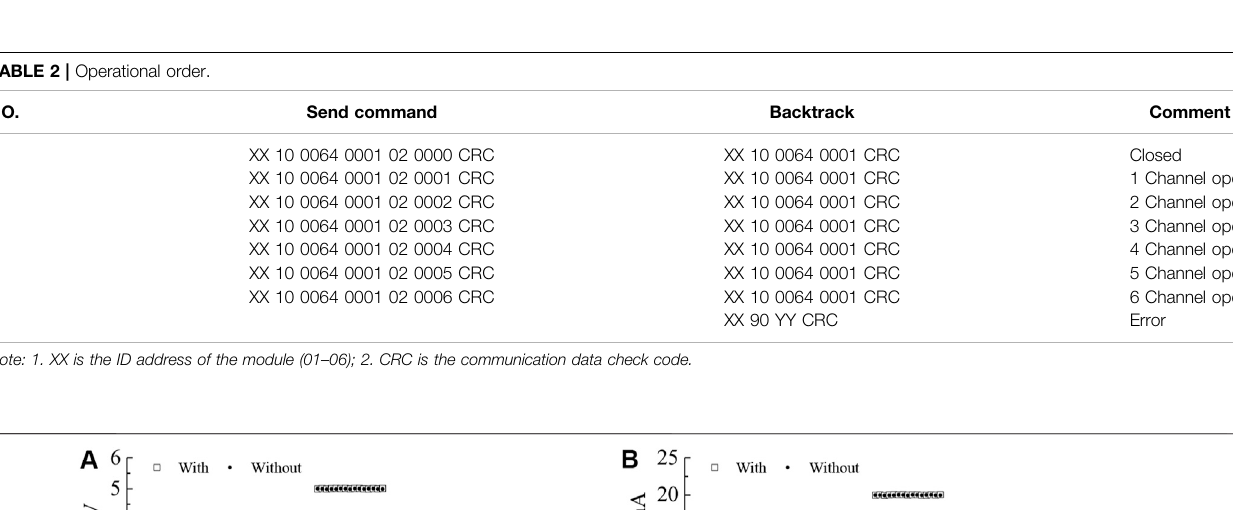
The three earth pressure sensors (voltage sensor) were loaded between the steel plate and soil block, soil block and U-shaped plate.